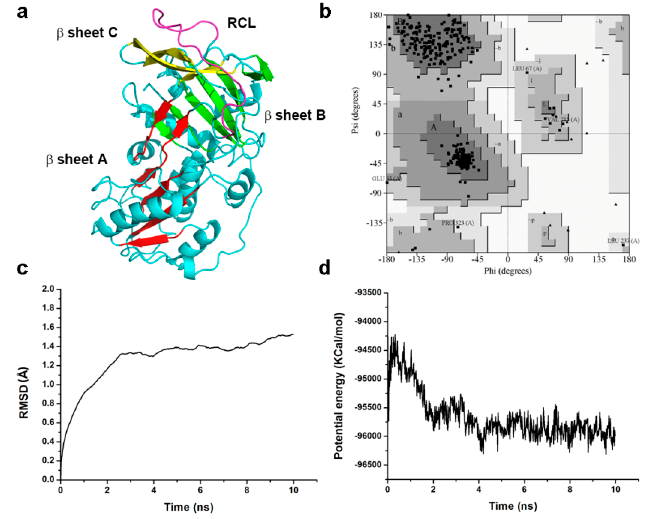
Table 2. The results of PROCHECK and Profile_3D verification.